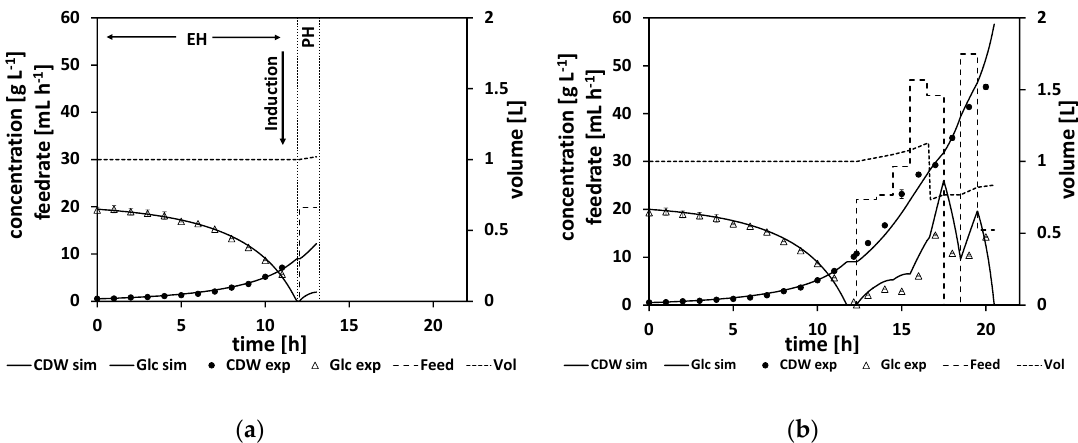
Figure 8. Time course of the glucose and biomass concentrations for fed-batch 3. Left side of the vertical dotted lines indicates the estimation horizon (EH): symbols mark samples, the samples were measured as three technical replicates, the lines mark the adapted simulated cultivation course (Model B + ), the dashed line shows the calculated feed profile, the dotted line marks the simulated reactor volume. Between the vertical dotted lines, indicating the prediction horizon (PH), the dashed line shows the optimized feed profile, the lines mark the extrapolated cultivation course, the dotted line marks the simulated reactor volume. ( a ) Prediction of the starting time point for the feed and calculation of the optimized first feed rate with the extrapolation starting time point τ = 12 h. ( b ) Finished process. For the parameter estimation results and the feed optimization results, see Tables A12–A14. For model equations, see Table A11 or Table